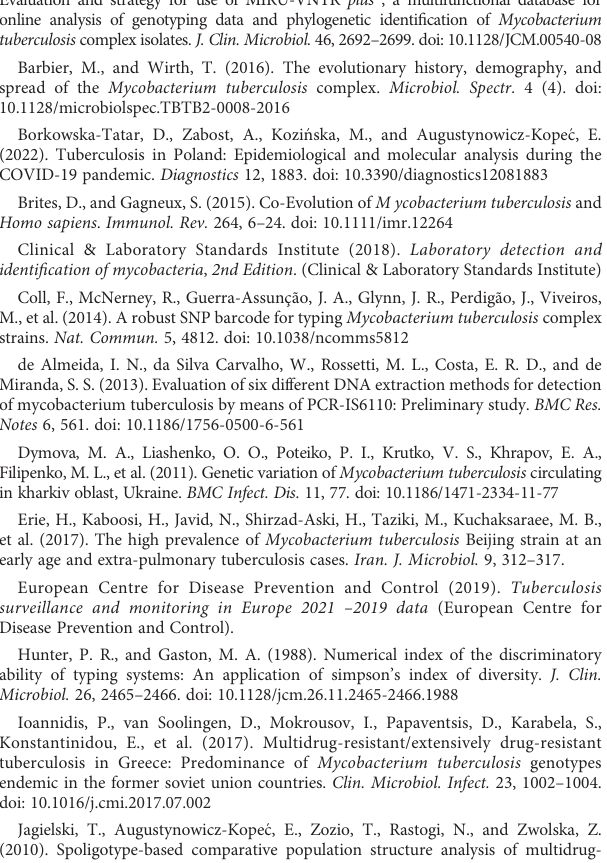
(yellow boxes, with either black or red borders, representing drug susceptible and multidrug-resistant isolates, respectively) and 186 reference isolates from SITVIT2 database (grey boxes). Only families identi fi ed in polish isolates are labeled. SUPPLEMENTARY TABLE 2 Data on 89 isolates included in this